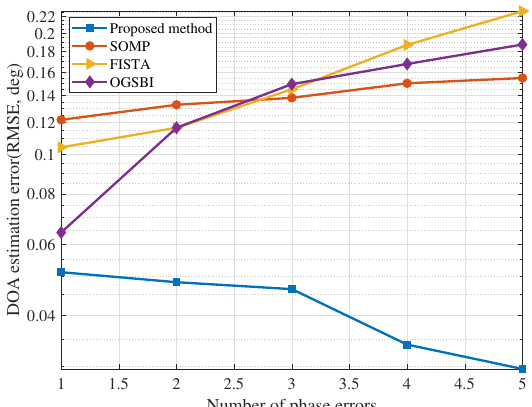
Figure 2. DOA estimation performance with different numbers of antennas.